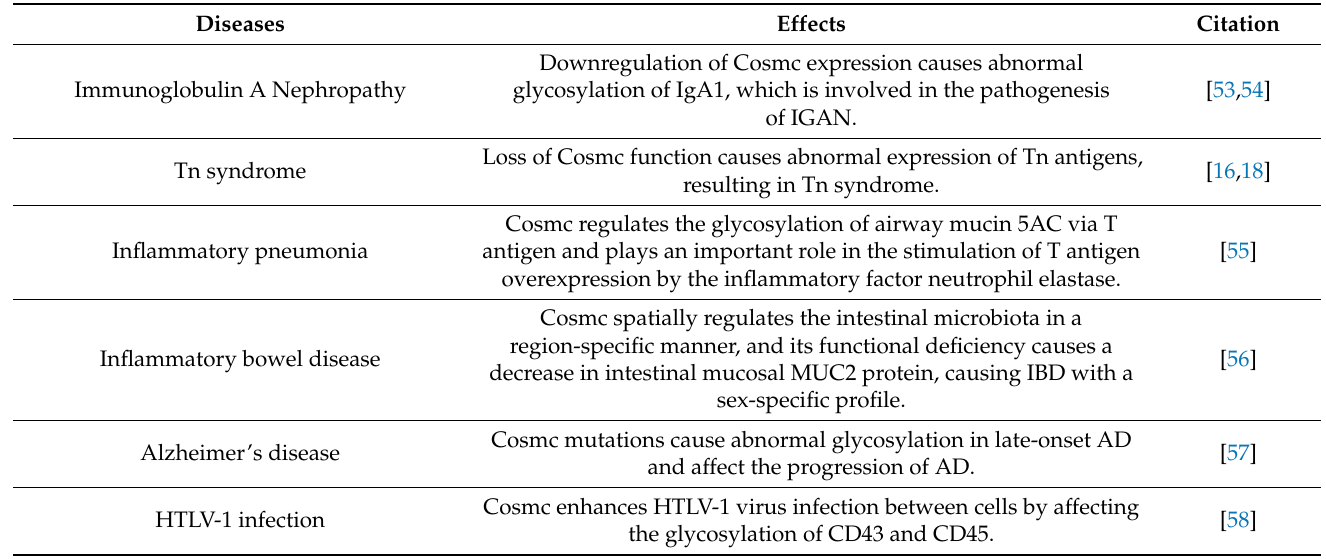
Table 2. Mechanism of Cosmc in non-neoplastic